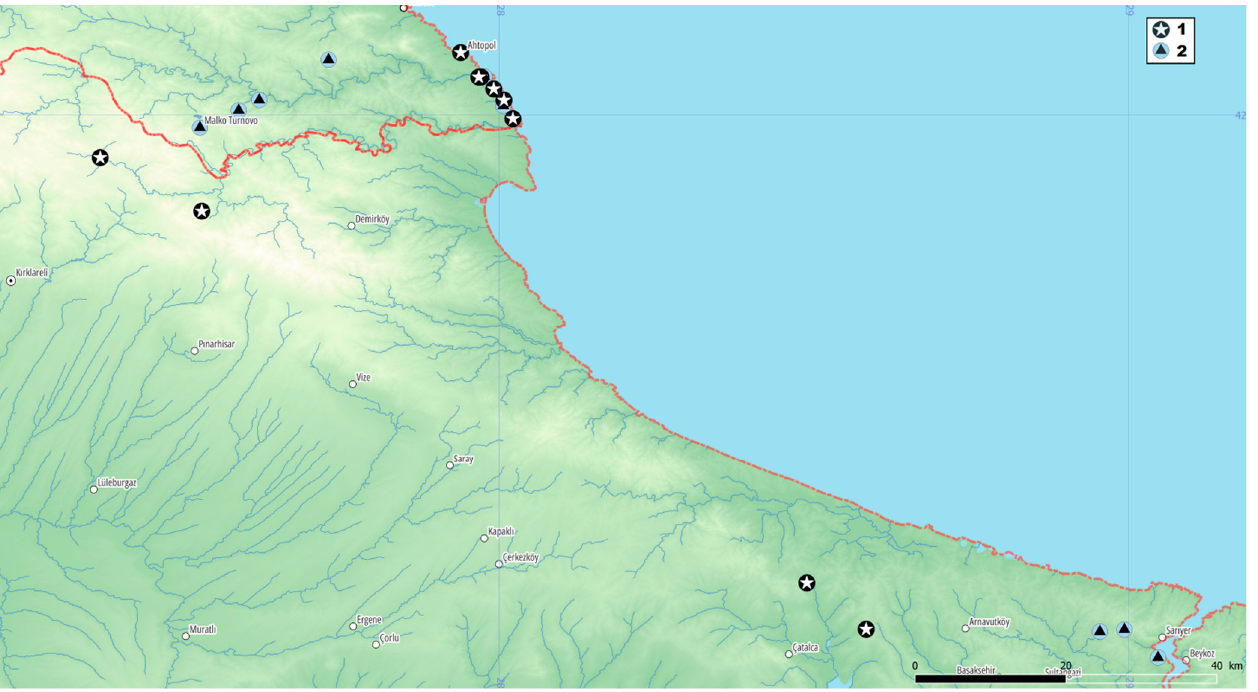
Figure 3. Occurrences in Bulgaria and Türkiye: (1) Crocus speciosus subsp. ibrahimii ; (2) C. pulchellus.